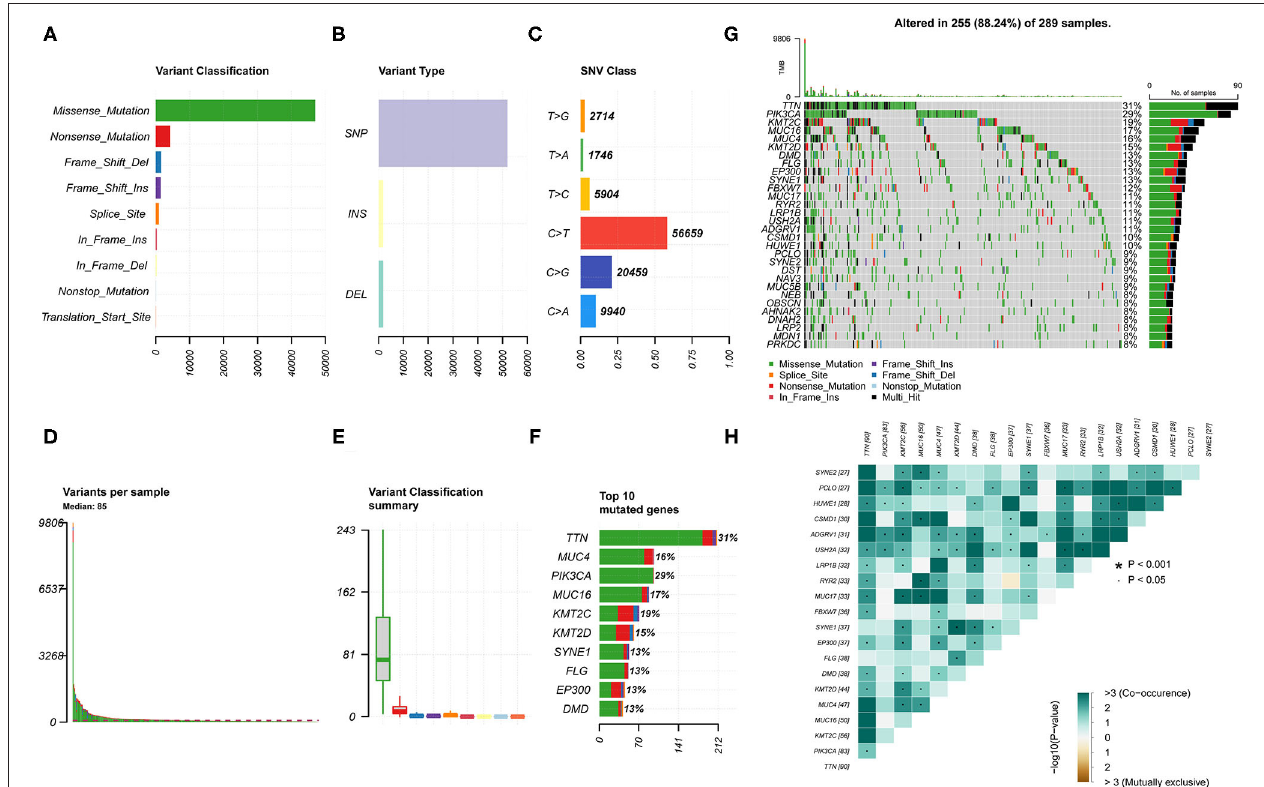
FIGURE 1 | Landscape of gene mutation in the cervical squamous cell carcinoma (CESC) samples. (A,B) Variant classification and variant types identified in CESC. (C) Single nucleotide variant (SNV) classes in CESC. (D) Number of variations in different samples. (E) Summary of the median value of variant classification. (F) Top 10 mutated genes in CESC. (G) Waterfall plot showing mutation information of frequently mutated genes in each sample. The bar plot above represents the tumor mutation burden. (H) Co-occurrence and mutually exclusive among mutated genes.